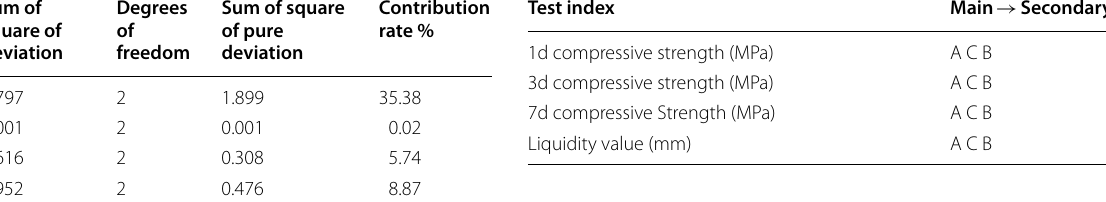
Table 17 Contribution rate results of factors and errors under compressive strength at 16 1d Factor Sum of square of